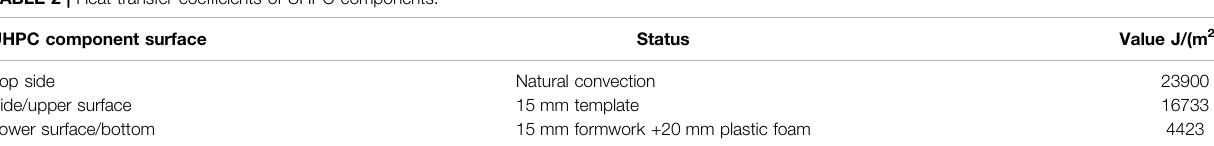
TABLE 2 | Heat transfer coef fi cients of UHPC